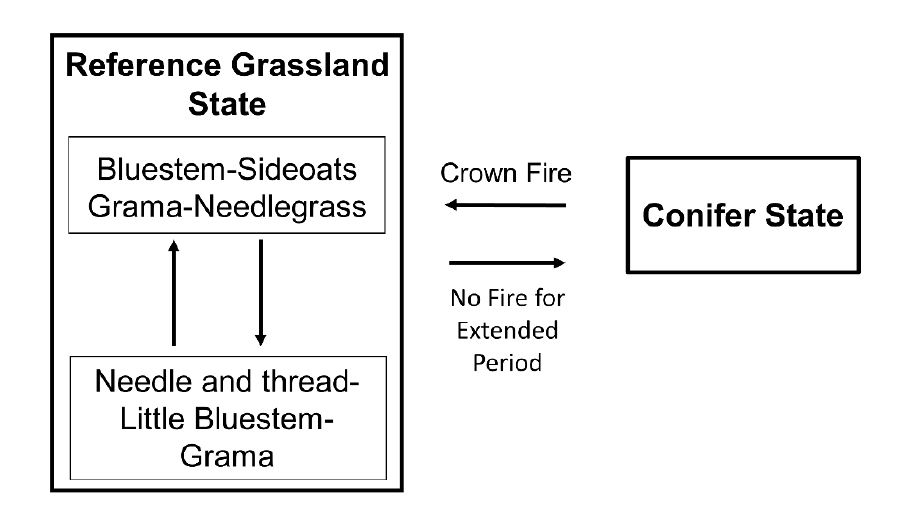
Figure A1.1. A simplified state-and-transition model (STM) from the USDA Ecological Site Descriptions for the ‘Shallow’ ecological site in the Mixed Sandy and Silty Tableland and Badlands Major Labe Resource Area before its alteration in 2019. The STM has been simplified to only highlight the role of fire. Bold outlined boxes denote alternative ecological regimes (also termed states). Arrows represent a transition between ecosystem states (bold boxes) or community phases (light boxes). Words next to arrows represent where fire is a proposed driver of